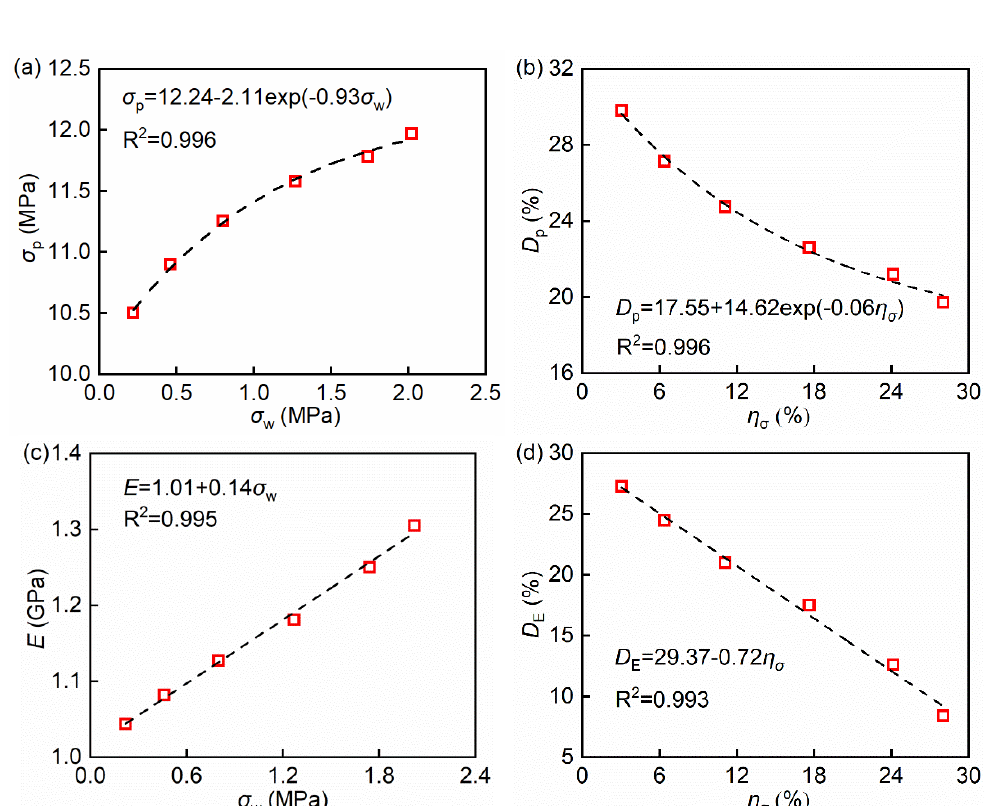
Figure 8. The σ p , E , D p , and D E for weak interlayer with different uniaxial compressive strength: ( a ) peak strength of the samples; ( b ) weakening effect index of weak interlayer on sample peak strength; ( c ) elastic modulus of the samples; ( d ) weakening effect index of weak interlayer on sample peak strength.